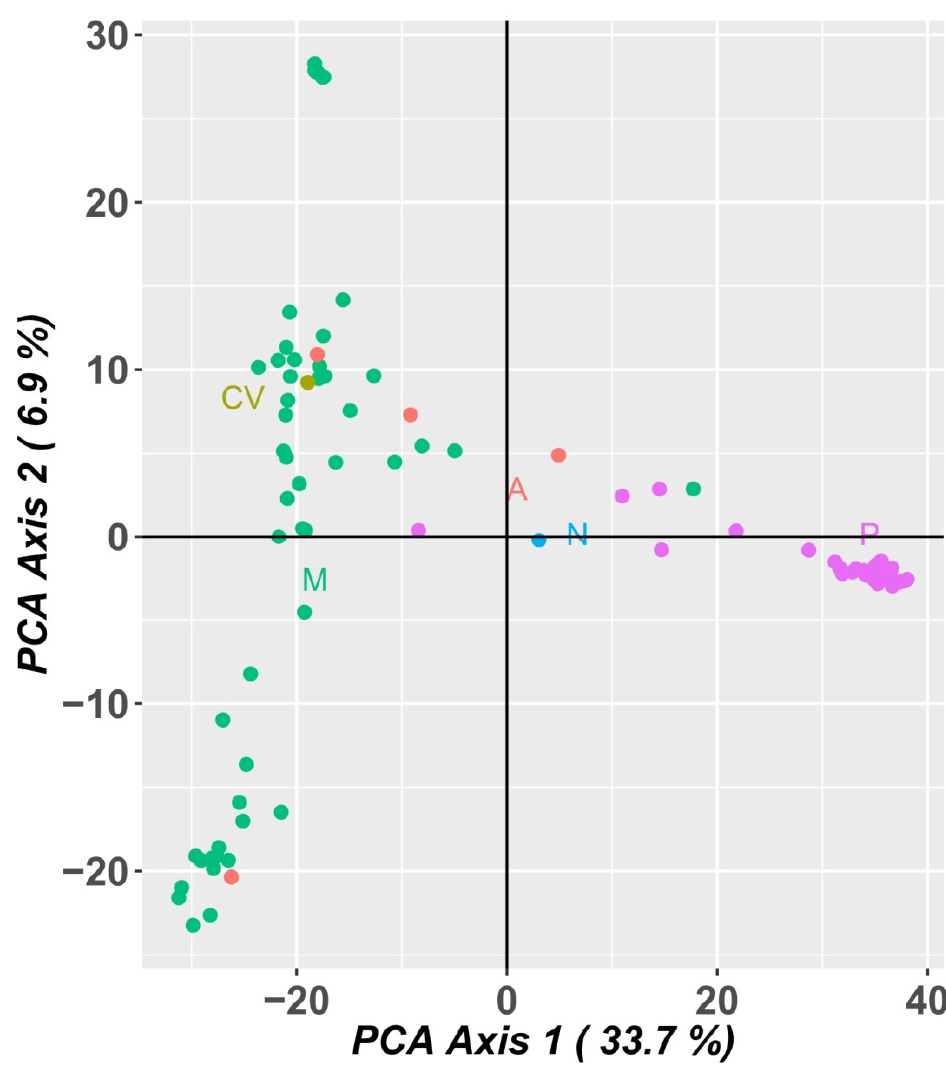
Figure 8. Principal component analysis (PCA) of SilicoDArT markers showing allelic variation among 92 cowpea accessions. Dots represent individual accessions grouped by country (green: Mozambique; olive green: Cape Verde; orange: Angola, blue: Nigeria and pink: Portugal).